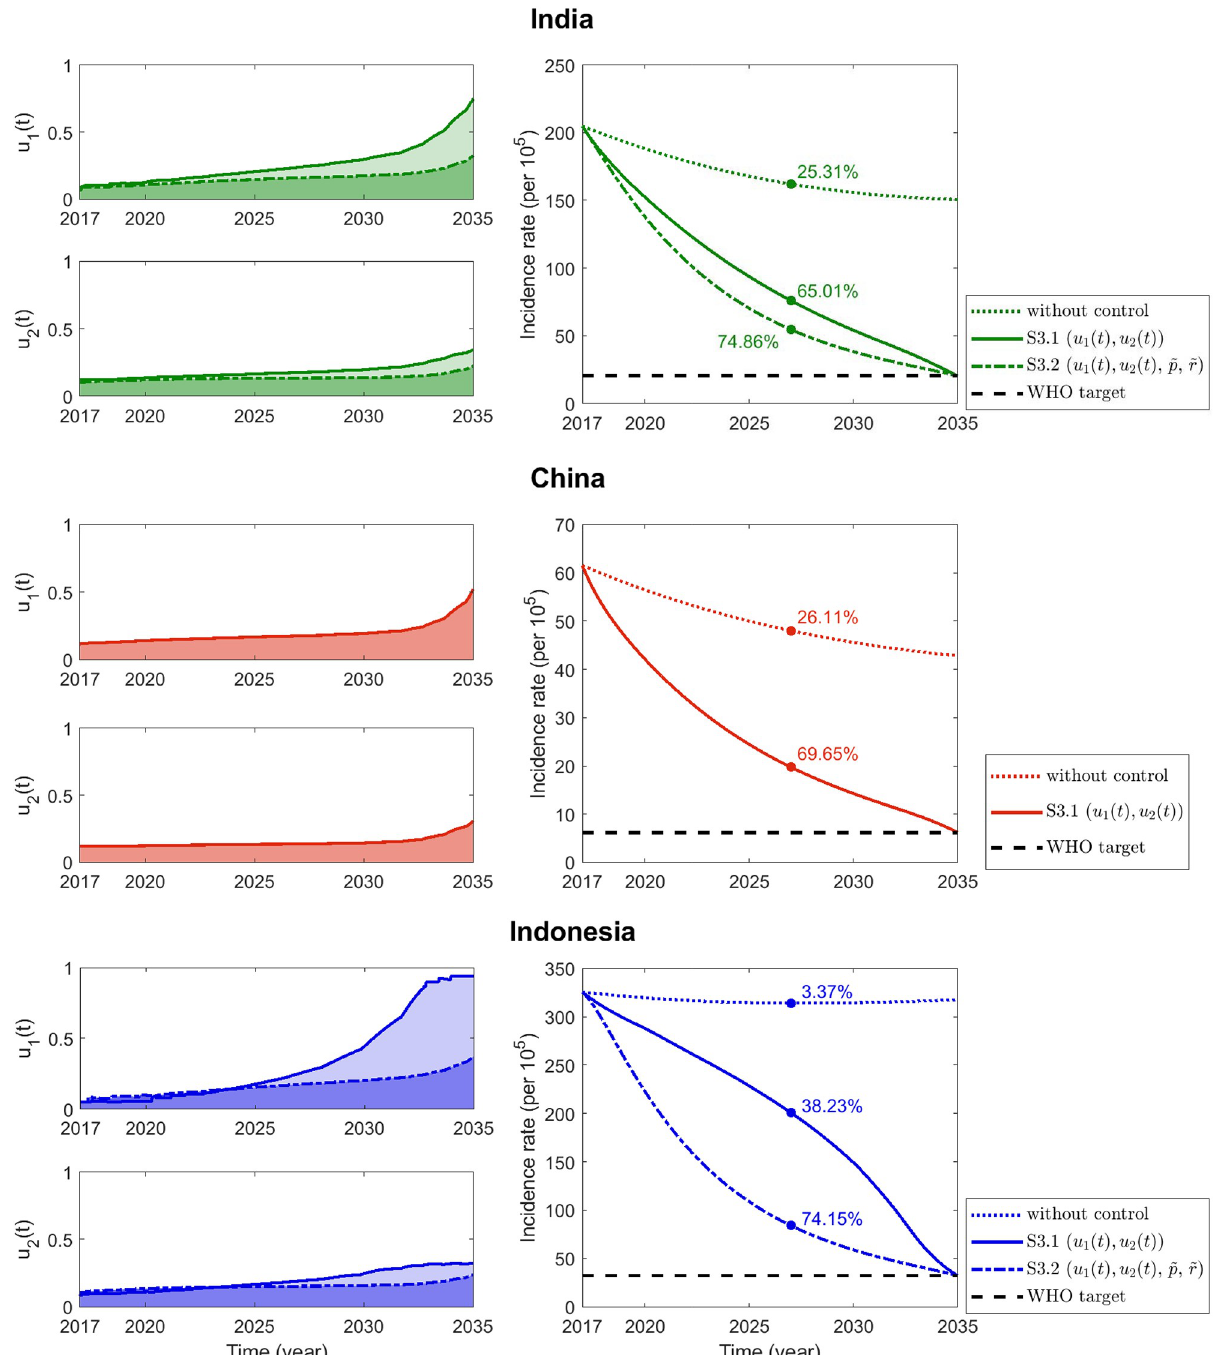
Fig 8. Scenario 3: Coupled control strategy. The left frames depict optimal control strategies with constant case holding and active case finding controls (dash-dotted) or without the two constant controls (solid), as functions of time. The right frames show the corresponding incidence rates and the WHO targets in 2035 (black dashed